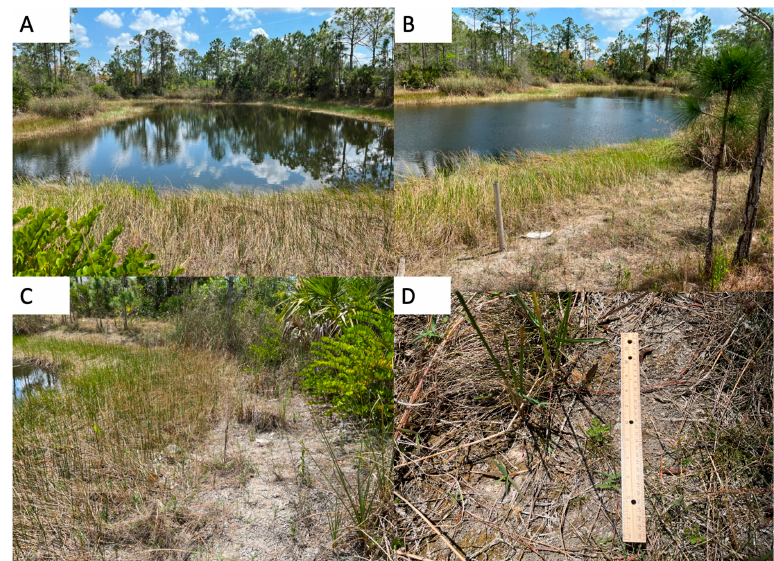
Figure 4. Pictures of the Police Pond taken in the dry season. ( A ) View facing south showing the heavily vegetated shoreline colonized completely by spikerush. ( B ) View facing east shows more of the heavily vegetated shoreline with some exposed shoreline. ( C ) View along a section of shoreline showing some unvegetated patches alternating with spikerush patches. ( D ) Close-up view of exposed soil patch showing some spikerush and other vegetation, as well as detritus covering. Algal mats were also present. Coring of the sediment in the SWI of each pond bed was conducted at the numbered locations in Figure 3. These locations included peripheral sites that occurred on the edge of the water and at varying depths within the pond. Therefore, all the coring sites were fully saturated with water at the time of sampling. Further, all cores were retained in their original vertical orientation throughout the study. The cores were obtained by driving 8.9 cm (outer diameter, 0.635 cm wall thickness) clear acrylic tubes into the sediment. The minimum, maximum, mean, and median values of the sediment core lengths can be found in Supplementary Data Table S1. The tubes contained a one-way check valve at the top to